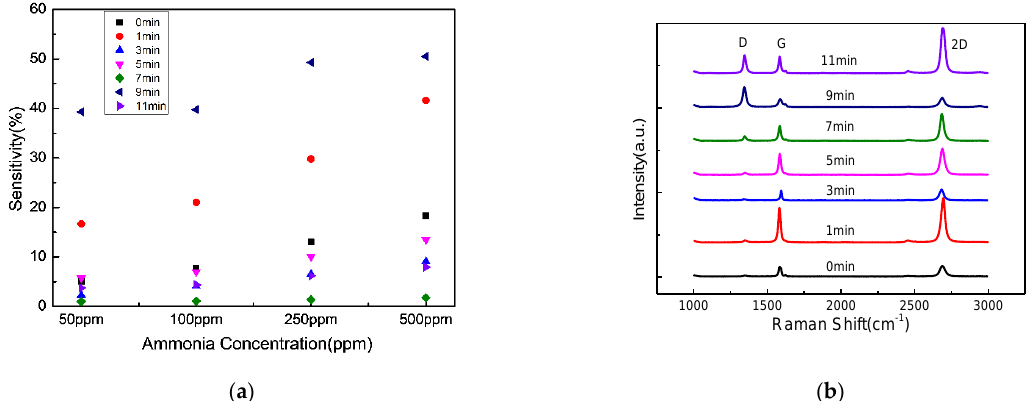
Figure 6. Sensitivity ( a ) and Raman spectrum ( b ) of ion sensitive GO-Si based metal-semiconductor junction resistor gas sensor with different time lengths of UVO processing.